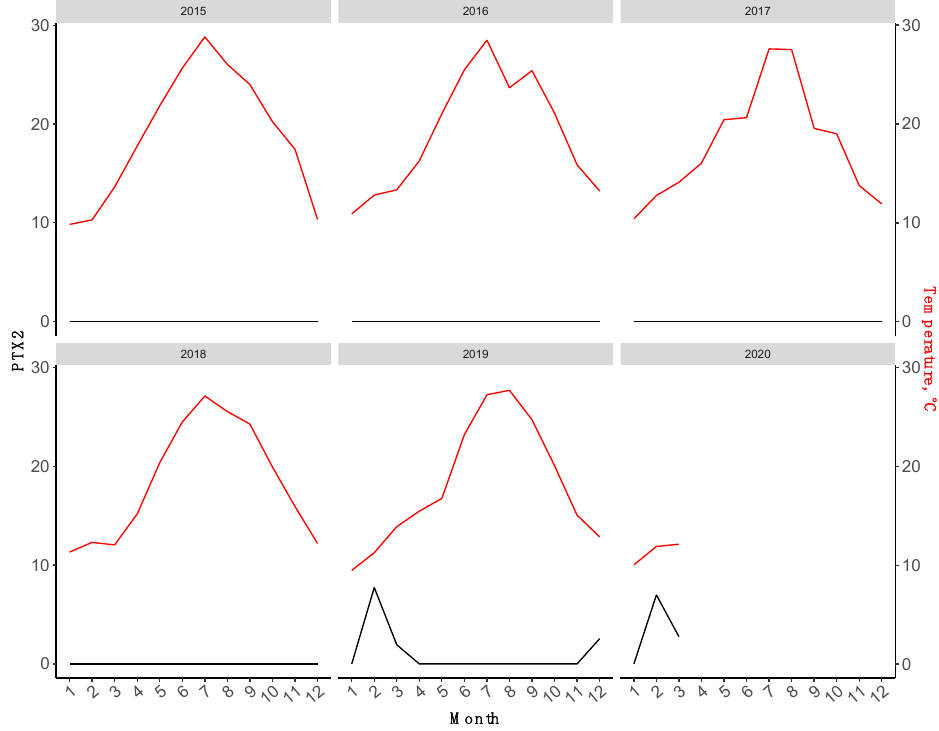
Figure 4. The annual trend of pectenotoxins2 for each analyzed year, and the trend and concentration of pectenotoxins2 in the tissues of the bivalve mollusks under study, in relation to the water temperature of the period.